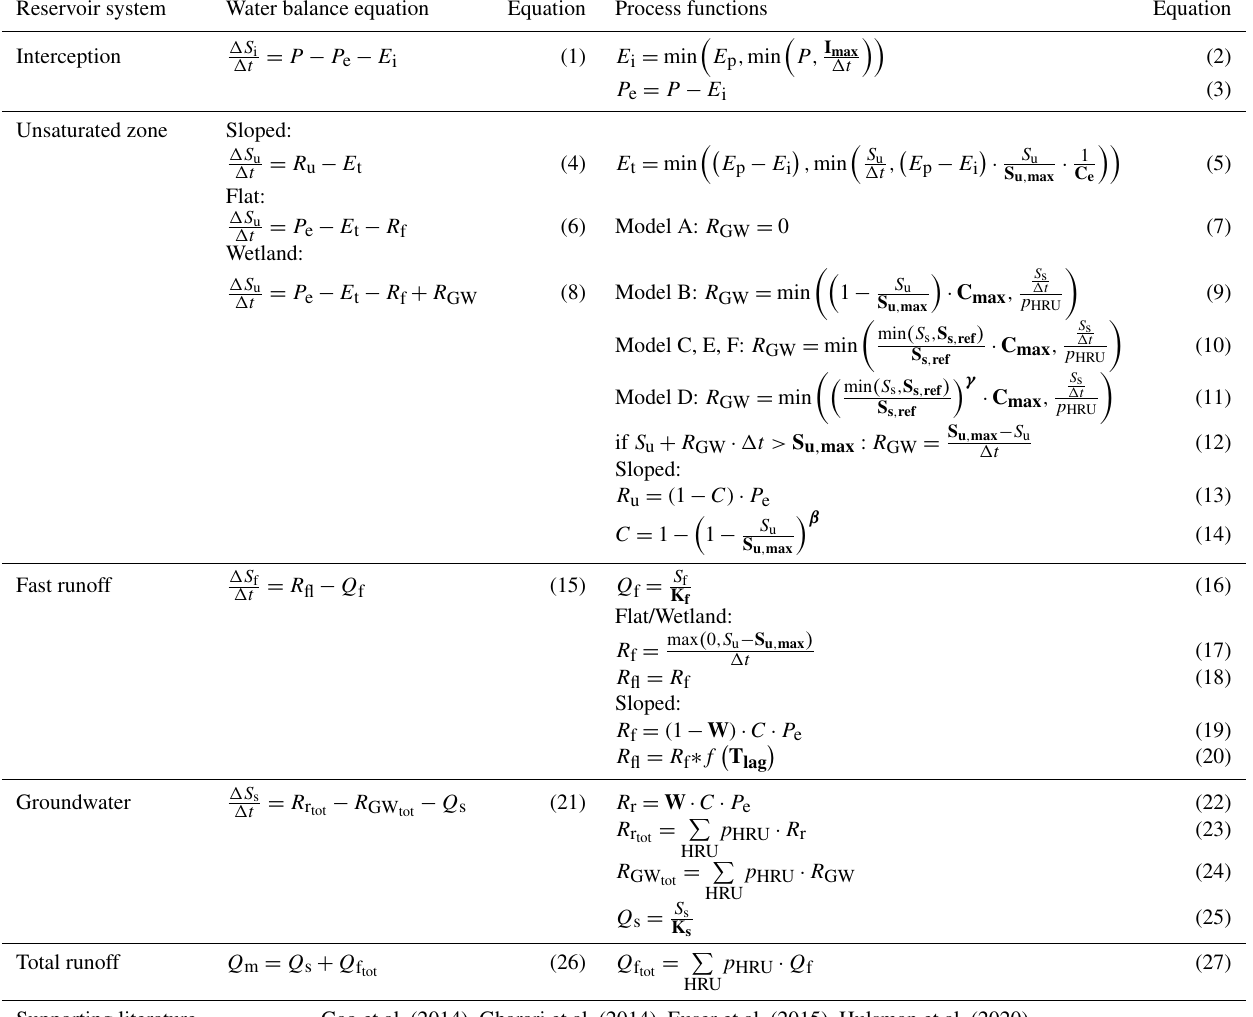
Table 2. Equations applied in the hydrological model. Fluxes [mmd − 1 ]: precipitation ( P ), effective precipitation ( P e ), potential evapora- tion ( E p ), interception evaporation ( E i ), plant transpiration ( E t ), infiltration into the unsaturated zone ( R u ), drainage to fast runoff compo- nent ( R f ), delayed fast runoff ( R fl ), groundwater recharge ( R r for each relevant HRU and R r , tot combining all relevant HRUs), groundwater upwelling ( R GW for each relevant HRU and R GW , tot combining all relevant HRUs), fast runoff ( Q f for each HRU and Q f , tot combining all HRUs), groundwater/slow runoff ( Q s ) and total runoff ( Q m ). Storages [mm]: storage in interception reservoir ( S i ), storage in unsaturated root zone ( S u ), storage in groundwater/slow reservoir ( S s ) and storage in fast reservoir ( S f ). Parameters : interception capacity ( I max ) [mm], maximum upwelling groundwater ( C max ) [mmd − 1 ], maximum root zone storage capacity ( S u , max ) [mm], reference storage in the saturated zone ( S s , ref ) [mm], splitter ( W ) [–], shape parameter ( β ) [–], transpiration coefficient ( C e ) [–], time lag ( T lag ) [d], exponent ( γ ) [–], reservoir timescales [d] of fast ( K f ) and slow ( K s ) reservoirs, areal weights for each grid cell ( p HRU ) [–] and time step ( (cid:49)t ) [d]. Model calibration parameters are shown in bold letters in the table below. The equations were applied to each hydrological response unit (HRU) unless indicated differently. Water balance equation Equation Process functions